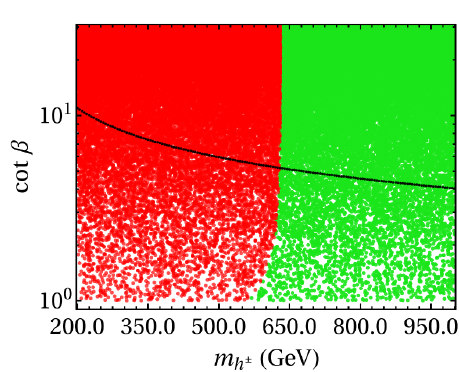
for the effective h ±